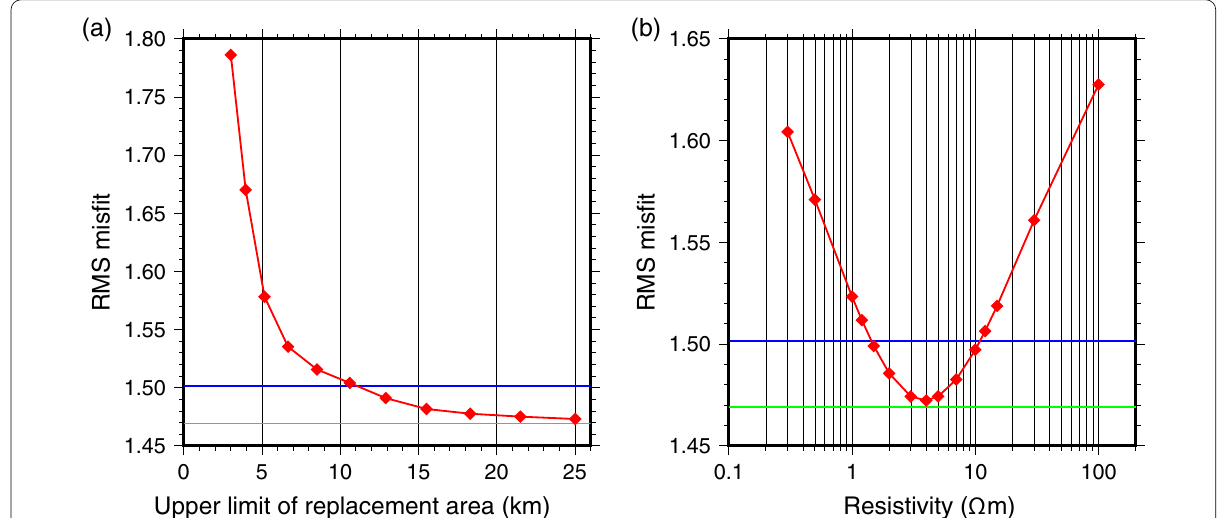
Fig. 4 Results of the sensitivity tests for the C-2 anomaly. The green lines are the RMS misfit of the inverted model and the blue lines show the limit of the 95% confidence interval of the F -test. a Upper limits of the zone of replacement of anomalous C-2 resistivities versus RMS misfit. b Resistivities used to replace anomalous C-2 resistivities versus RMS